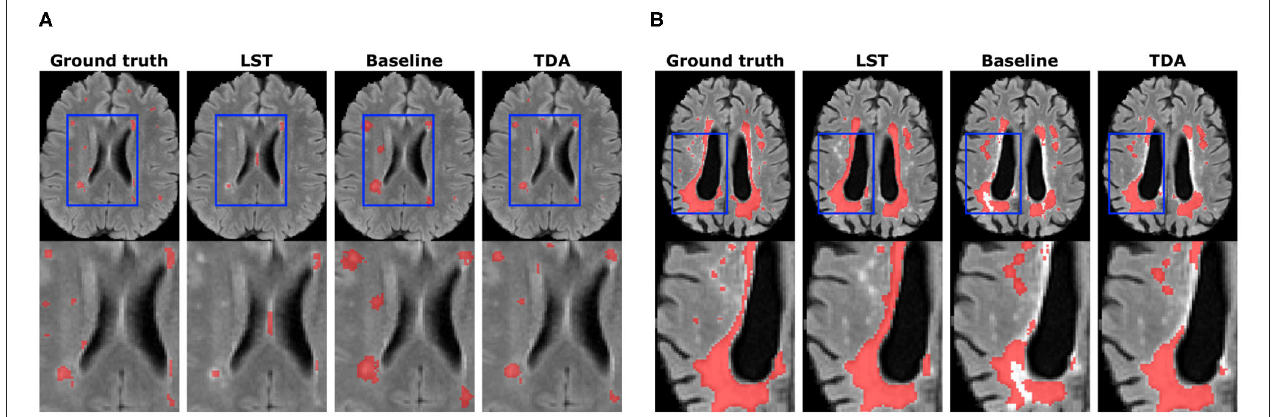
FIGURE 7 | Qualitative results for WMH lesion segmentation. Small lesion (A) and large lesion (B) segmentation improvements are shown. The bottom row depicts zoomed regions of interests shown in blue rectangles on whole-brain images (top